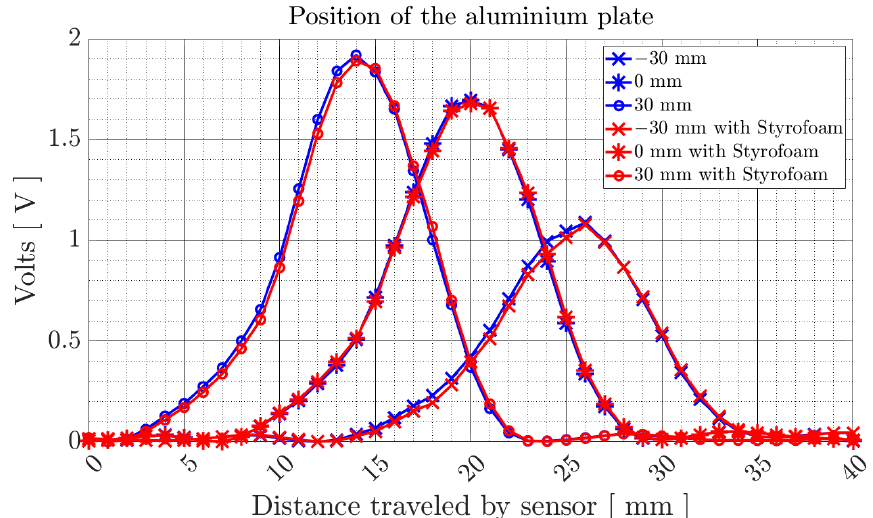
Figure 6. Results of the vertical level detection of the aluminium plate with or without Styrofoam covering.